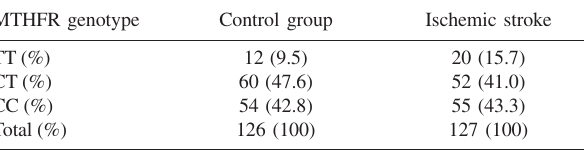
Table 2 - Distribution of 5,10-methylenetetrahydrofolate reductase genotypes in ischemic stroke cases and control group MTHFR genotype Control